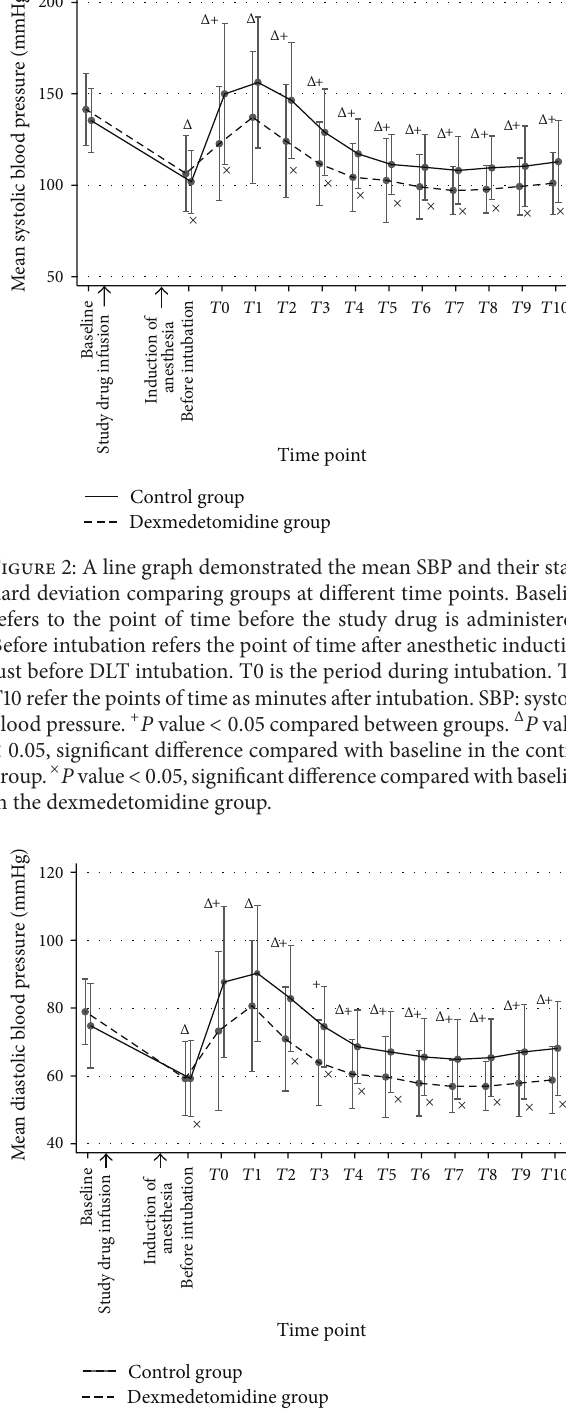
Figure 3: A line graph demonstrated the mean DBP and their stan- dard deviation comparing groups at different time points. Baseline refers to the point of time before the study drug is administered. Before intubation refers the point of time after anesthetic induction just before DLT intubation. T0 is the period during intubation. T1–T10 refer the points of time as minutes after intubation. DBP: diastolic blood pressure. + P value < 0.05 compared between groups. Δ P value < 0.05, significant difference compared with baseline in the control group. × P value < 0.05, significant difference compared with baseline in the dexmedetomidine